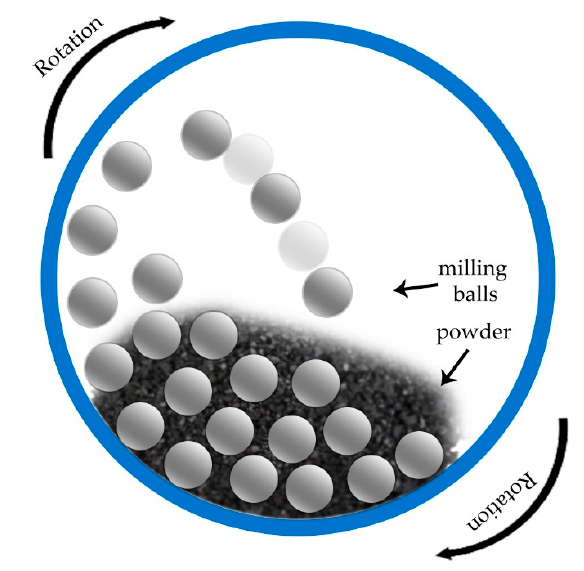
Figure 2. High-energy ball milling process.